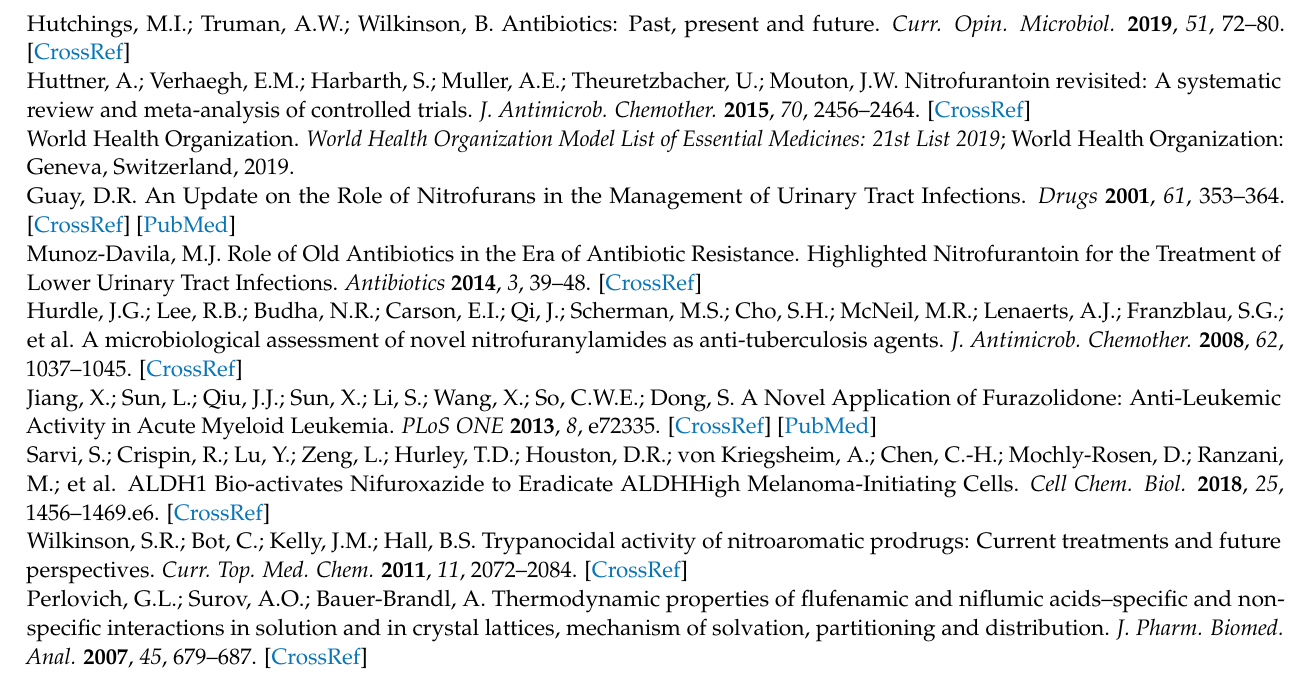
experiments, Figure S5: An overlay of powder X-ray diffractograms of (a) NFT and (b) FZL before and after the sublimation experiments, Figure S6: An overlay of the single crystal and optimized structures of (a) NFT and (b) FZL, Figure S7: Mole fraction solubility of NFT, NFT monohydrate and FZL in various solvents (buffer pH 2.0, buffer pH 7.4, 1-octanol) at different temperatures, Figure S8: PXRD analysis of the residual materials after solubility experiment of NFT in buffer pH 7.4 at 298.15 K from 1 to 60 min of experiment, Figure S9: Distribution diagram of the different species of NFT and FZL as a function of pH at 298.15 K, Figure S10: DCS/TG curves of NFT monohydrate obtained after solubility experiment in buffer pH 7.4 at 298.15 K, Fig: S11: Conventional and non- conventional hydrogen bonds formed by water molecules in the [NFT+H 2 O] (1:1) crystal, Table S1: Transpiration experiment parameters, vapor pressure of the investigated compounds at different temperatures, Table S2:, Comparison of calculated (B3LYP-D3(BJ,ABC)/6-31G(d,p) level of theory) and experimental thermodynamic properties of sublimation processes of NFT and FZL, Table S3: Compounds structurally similar to NFT and FZL, selected from the literature„ Table S4: Metric and electron-density features of hydrogen bonds formed by water molecules in the [NFT+H 2 O] (1:1) crystal and in the hypothetical [FZL+H 2 O] (1:1) crystal, Table S5: Density of the investigated solvents at different temperatures and constant pressure ( p = 0.1